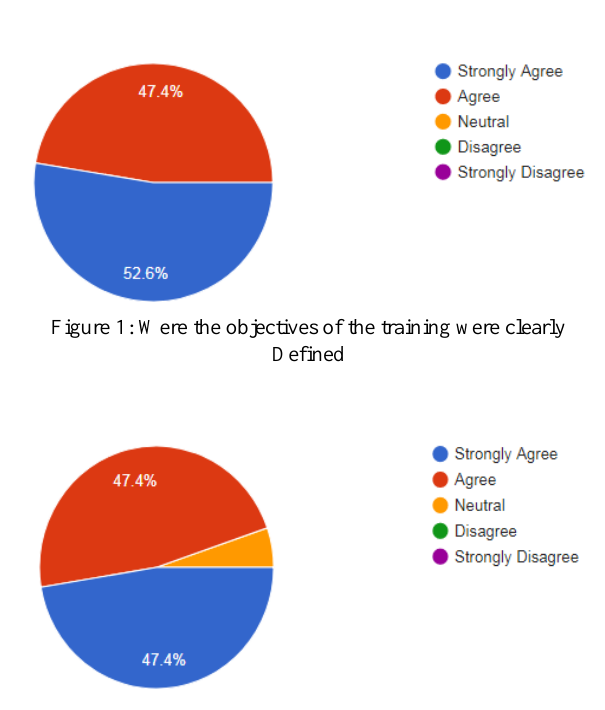
Figure 2: Was Participation and interaction encouraged